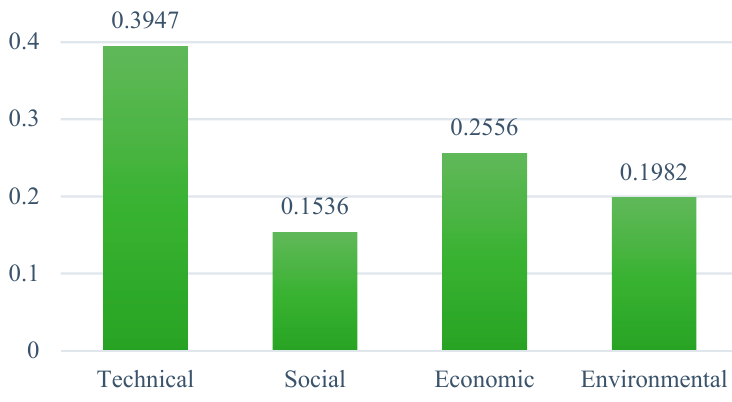
Figure 6. Priority weights of the main criteria.